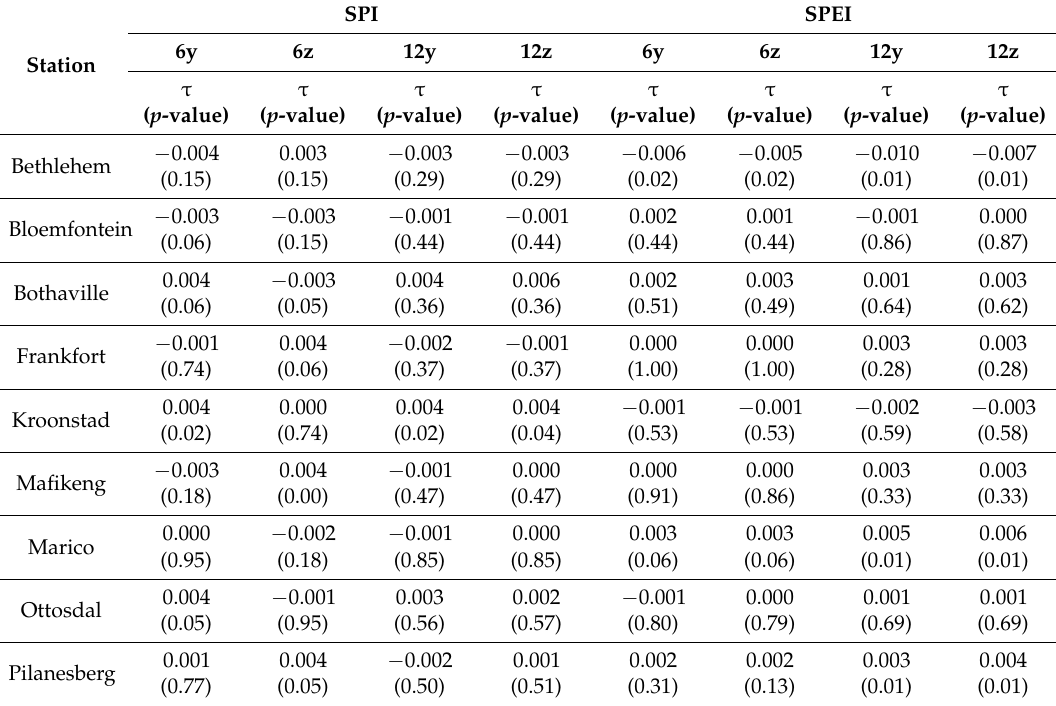
Figure 3. Trends (mm/year) in SPI/SPEI-6 and SPI/SPEI-12 indices based on: ( a ) Yue and Pilon (2002) (“y”) method [48]; and ( b ) Zhang (2000) (“z”) method [47]. Table 4. Results of the trend test applied to DTS and the corresponding significance.